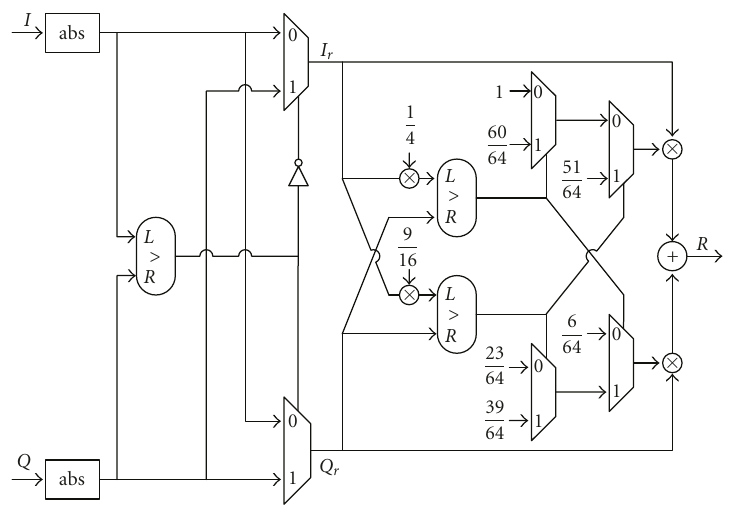
Figure 5: Implementation of the amplitude approximation with three angular intervals.